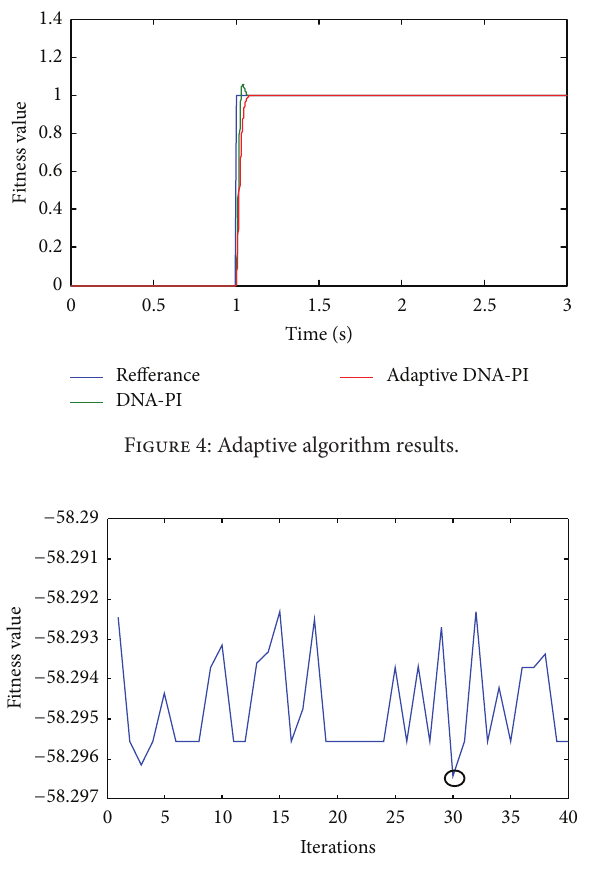
Figure 5: The fitness values of adaptive DNA computing algorithm.